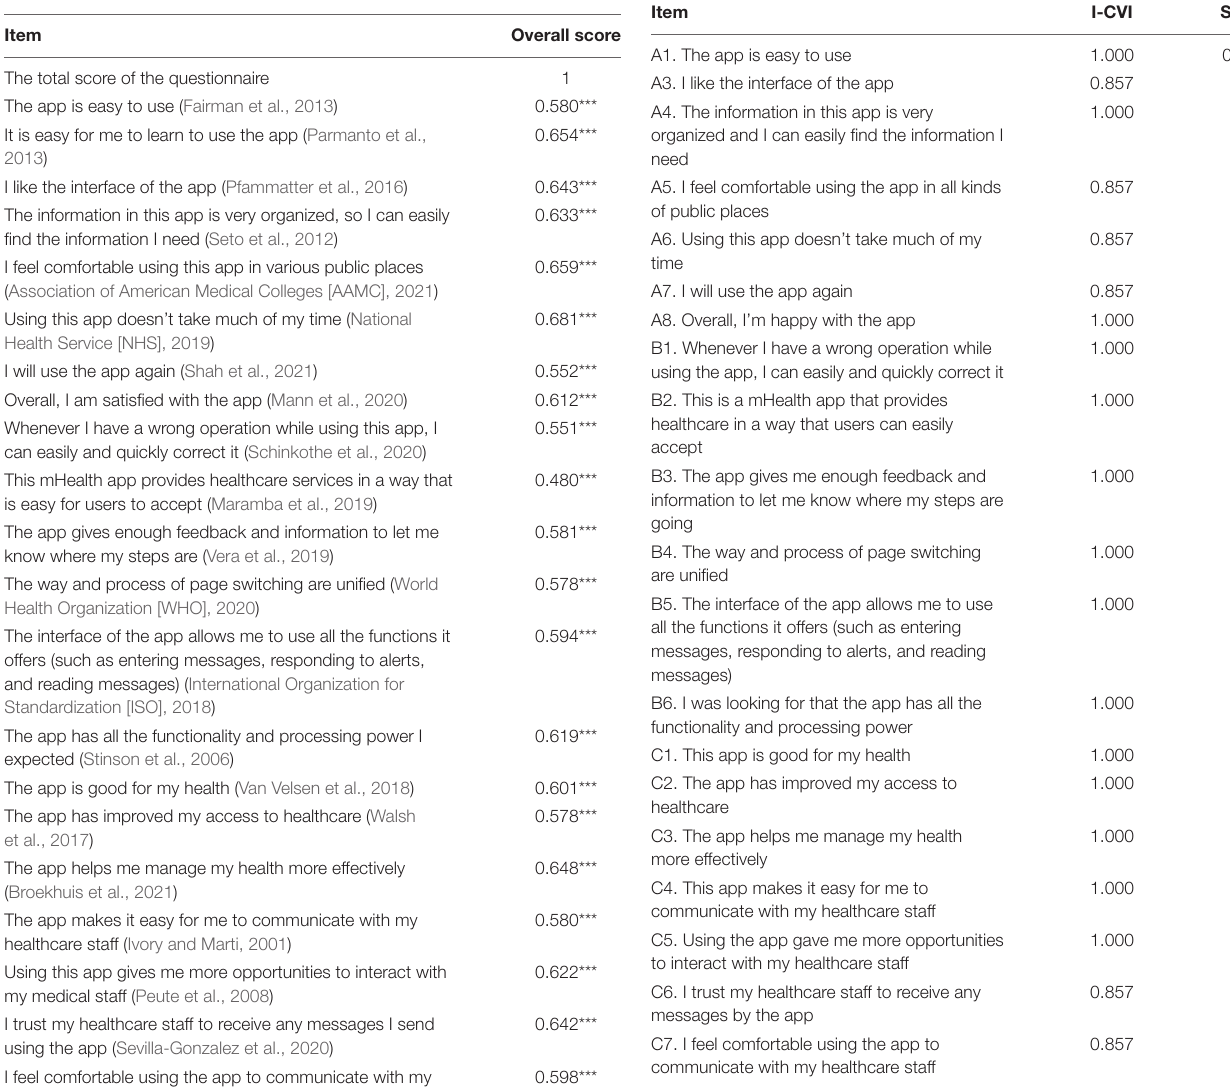
TABLE 4 | Content validity of the questionnaire.